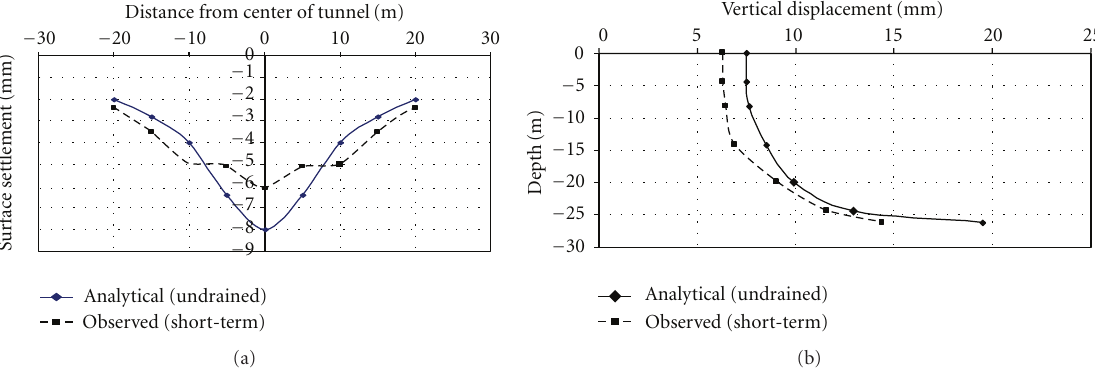
Figure 1: Green park underground tunnel: (a) surface settlement; (b) subsurface settlement (after [11]).